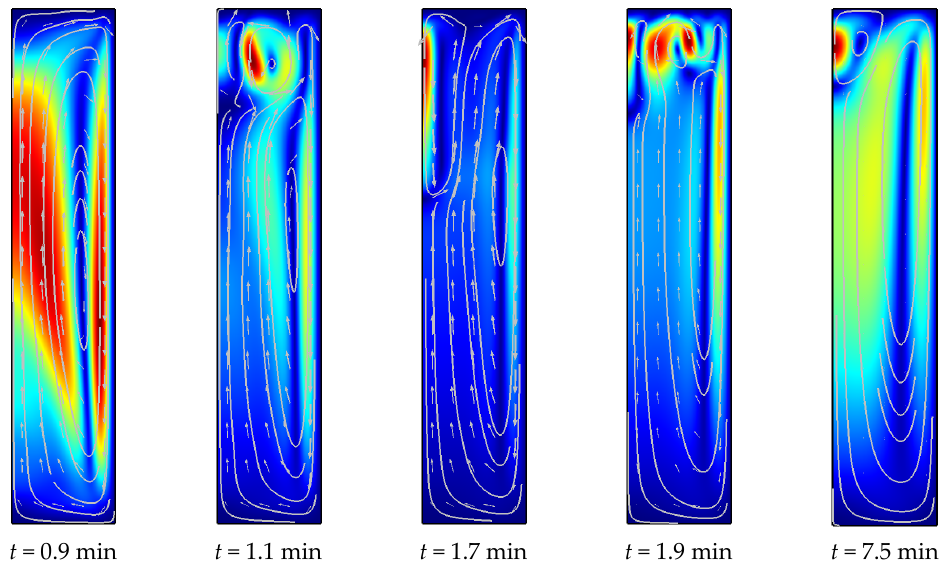
Figure 5. Flow patterns shown by velocity magnitude and arrows in the half cylinder cross-section for the cooling experiment (maximum velocities in the subplots from left to right: 3.1, 4.2, 3.7, 2.1, 1.3, 0.34 mm/s).